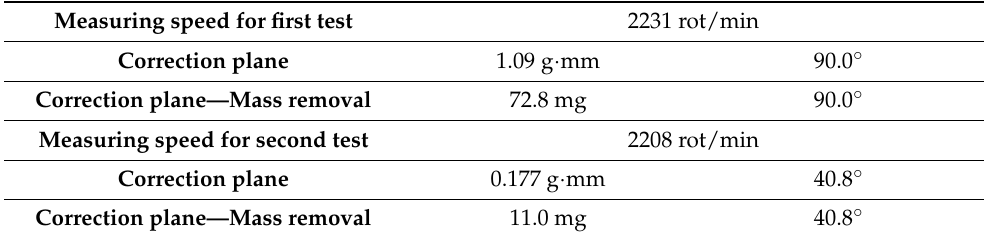
Table 7. Closed impeller balancing